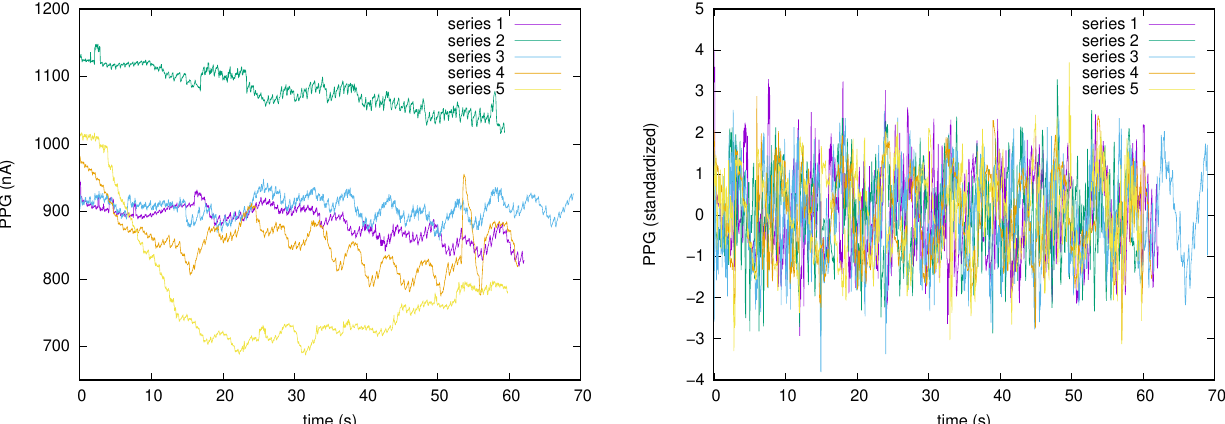
Figure 5. PPG data from subject 1, recorded during the squat activities, as originally acquired ( left panel ) and after standardization on non-overlapping windows of 1200 samples ( right panel